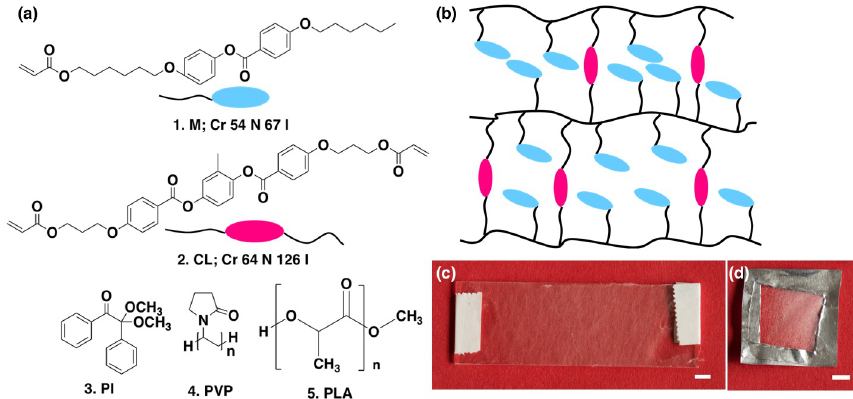
Figure 1. Fiber composition: ( a ) Chemical structure of: 1. reactive monomer (M); 2. cross-linker (CL); 3. photo-initiator (PI); 4. polyvinylpolypyrrolidone (PVP) and 5. polylactic acid (PLA); ( b ) Schematic showing LCE network formed by reactive monomer and cross-linker (the smectic-like organization is only due to the simplified drawing; the real LCE should be nematic); ( c ) LCE-PVP fibers spun on glass and polymerized at 55 ◦ C and ( d ) the same type of fibers spun free-hanging on a frame (scale bars: 5